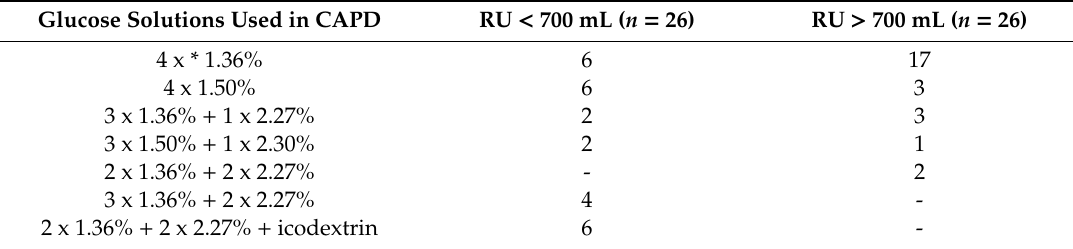
Table 2. Schedule of continuous ambulatory peritoneal dialysis (CAPD). Distribution of patients based on the concentrations of PD solution used and the number of dialysis exchange is given, in relation to the levels of residual urine